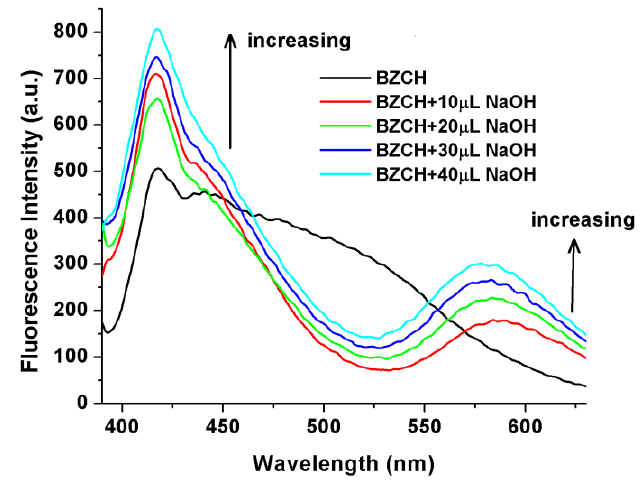
Figure 4. Fluorescence spectra of pure BZCH in DMSO solution and after the addition of dilute NaOH solutions. Excitation wavelength used was the corresponding absorption maximum.